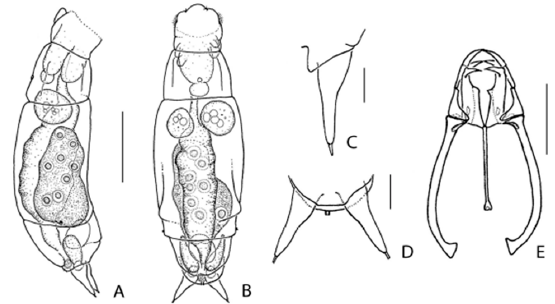
Figure 2. Encentrum melonei sp. nov. ( A ) Female, lateral. ( B ) Female, dorsal. ( C ) Toe, lateral, right. ( D ) Toes, dorsal. ( E ) Trophi, ventral. Scale bars: ( A , B ): 50 µm; ( C − E ): 10 µm.